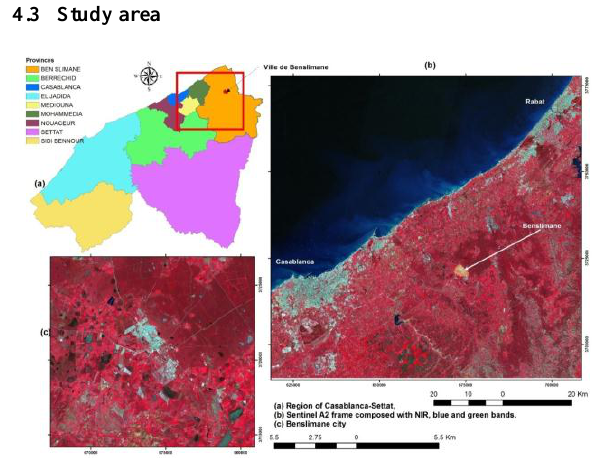
Figure 3. Location of the study area